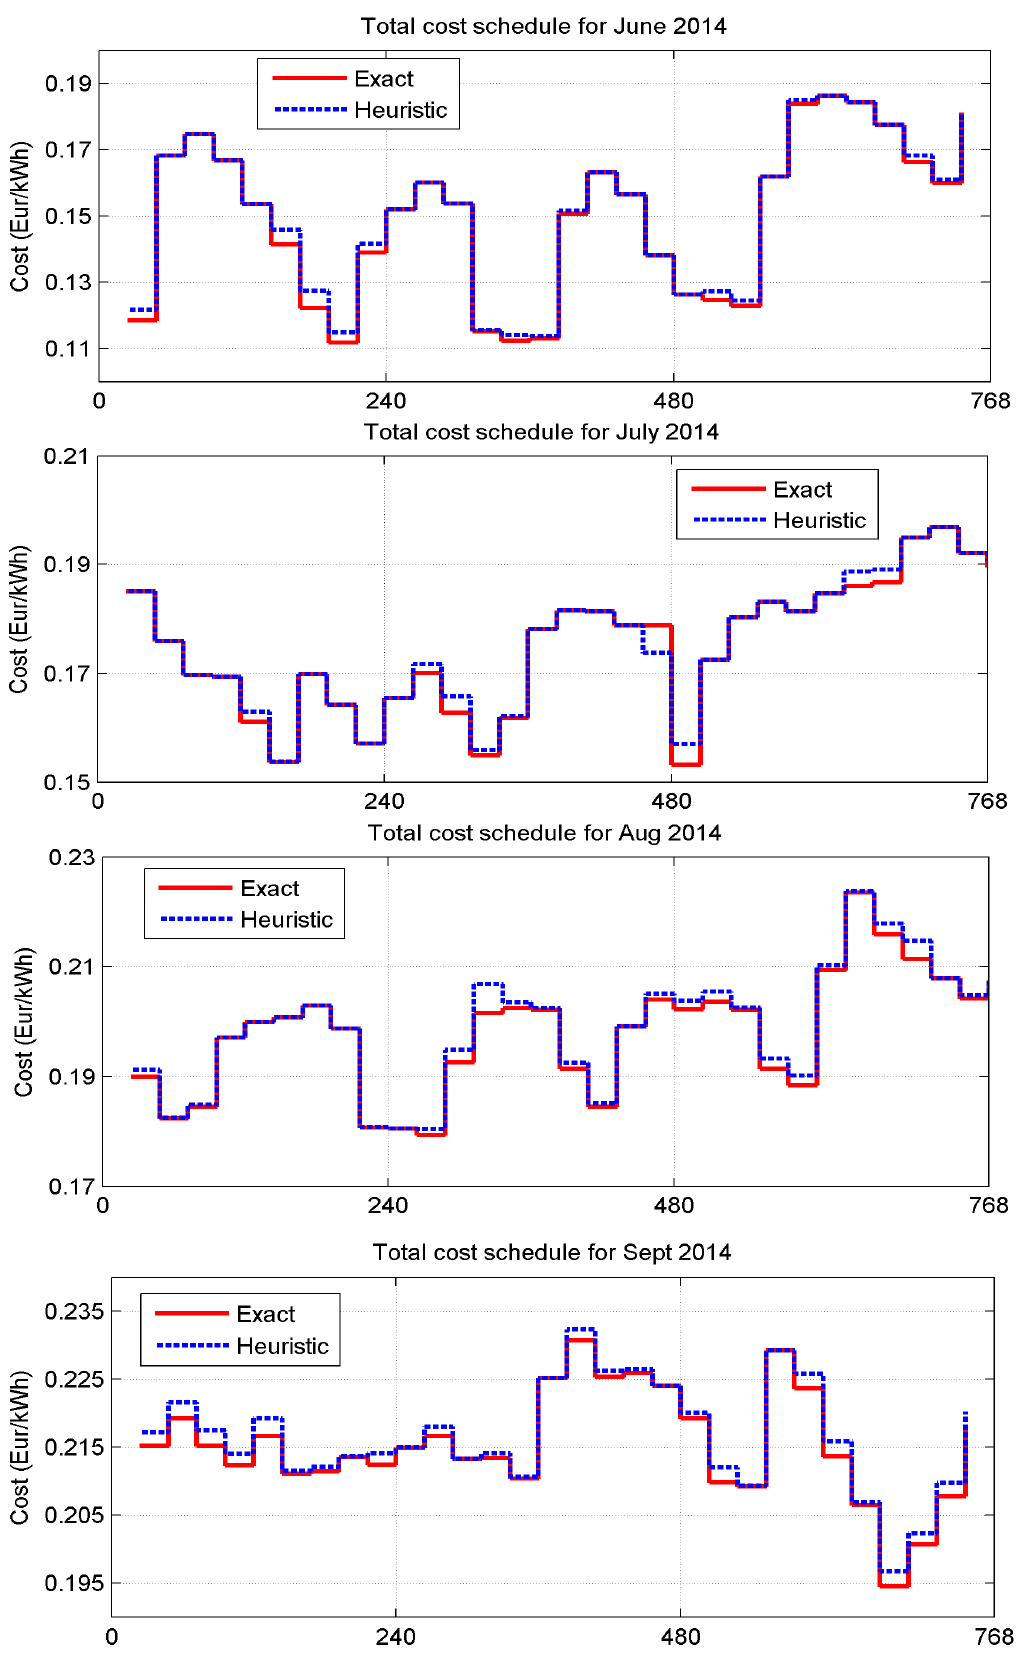
Figure 4. Cont Figure 4. Cont .